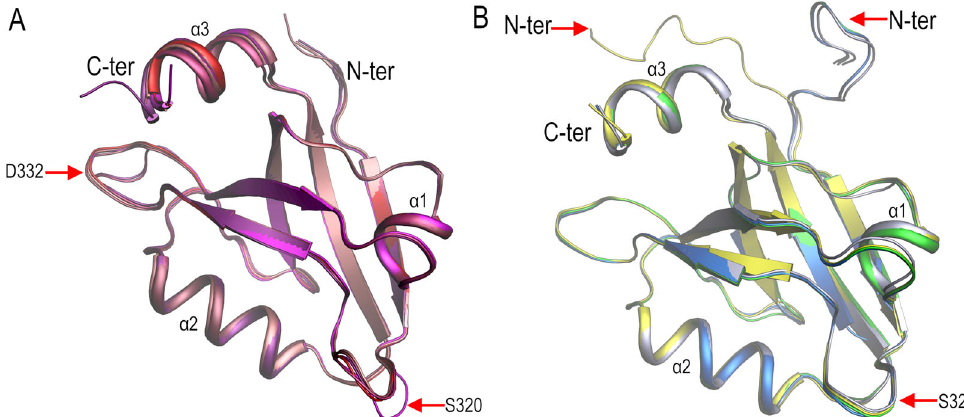
Figure 2. ( A ) Cartoon representation of the six chains in the trigonal structure (PDB entry 8AH4) coloured in red-magenta. The backbone atoms’ rmsd value is lower than 0.5 Å, and the main differences are found in the first β -turn containing S320, next to the canonical binding site, the second β -turn (red arrows) and the extra third α -helix. ( B ) Cartoon representation of orthorhombic-A (blue, PDB entry 8HA5) and orthorhombic-B (yellow, PDB entry 8AH7) superposed to chains A (green) and B (grey) of the monoclinic structure (PDB entry 8AH6). The main differences are in the first β -turn containing S320 and the N-terminal region (red arrows), where the monoclinic structure is like orthorhombic ‐ A, while orthorhombic ‐ B residues 301–309 are modelled differently.